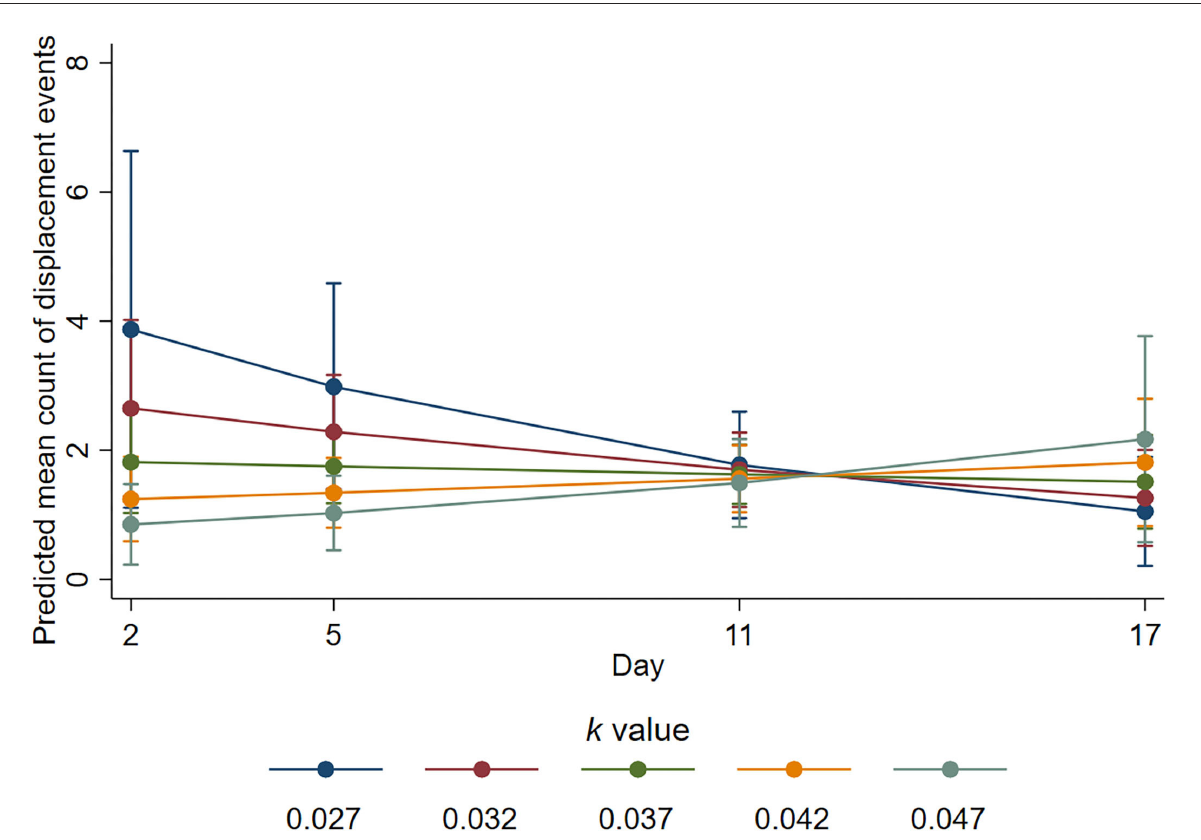
FIGURE5 Predicted mean counts of displacement events during the active observation for all k -value treatments on each observation day. Error bars represent 95% confidence intervals of predicted mean